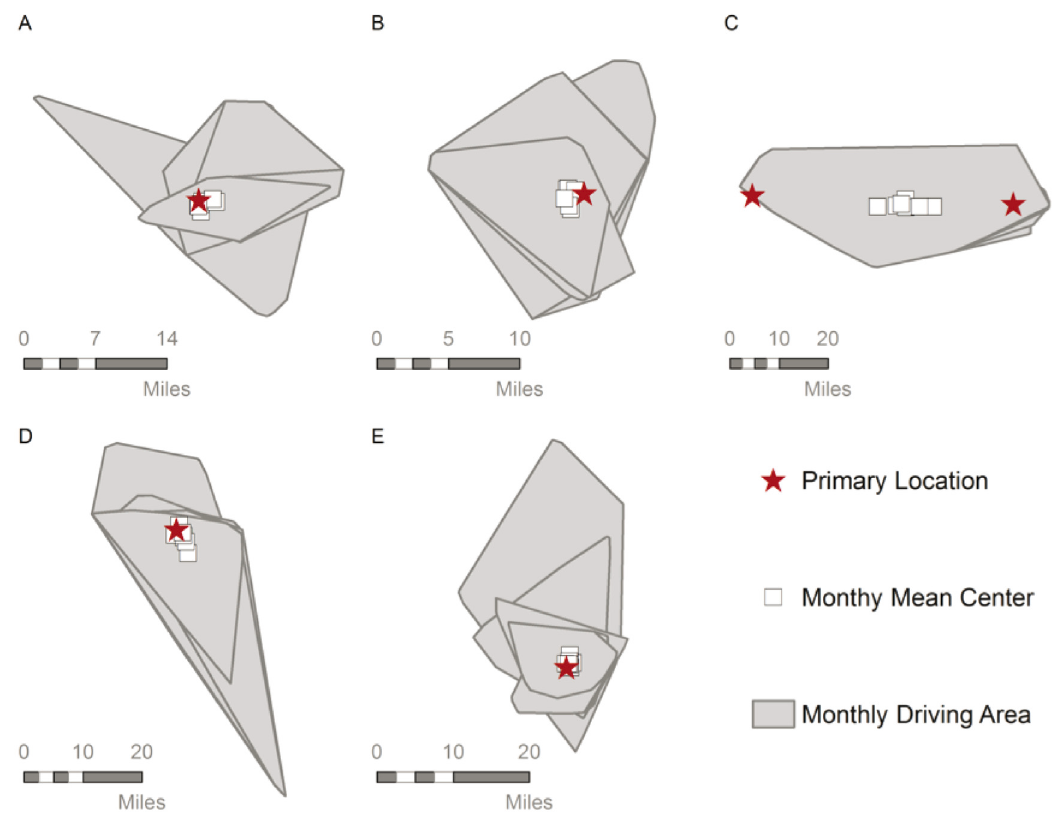
Figure 5. Spatial